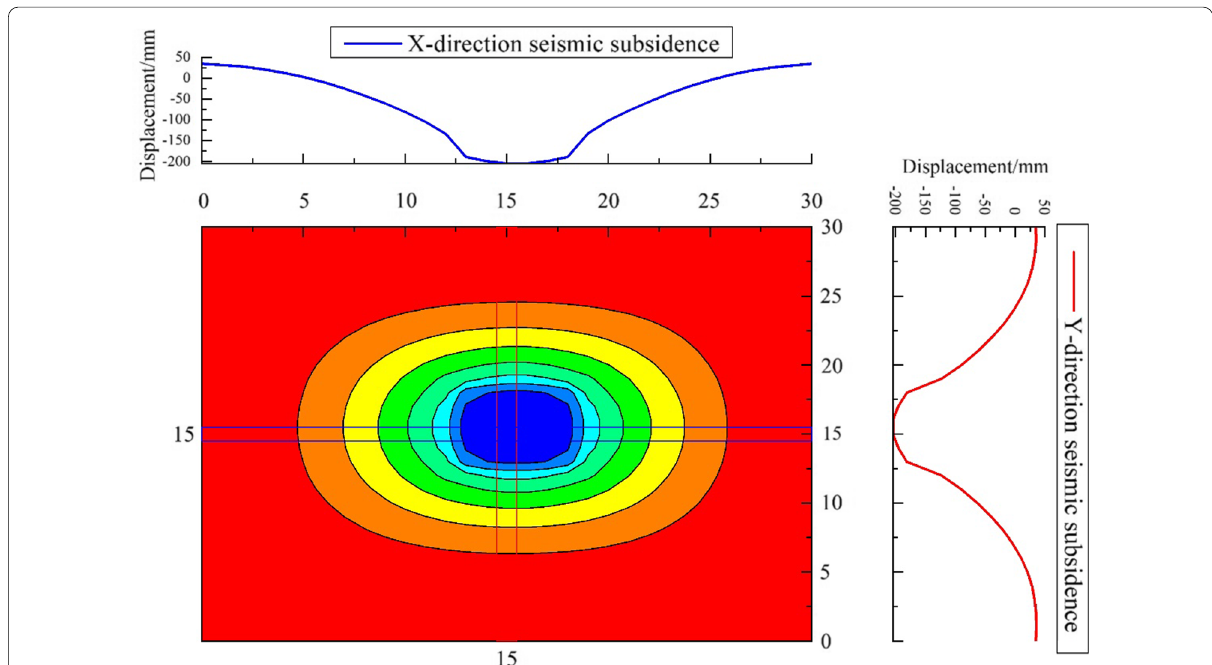
Fig. 9 Seismic subsidence of ground surface due to 0.30 g El Centro ground motion (cross-sectional